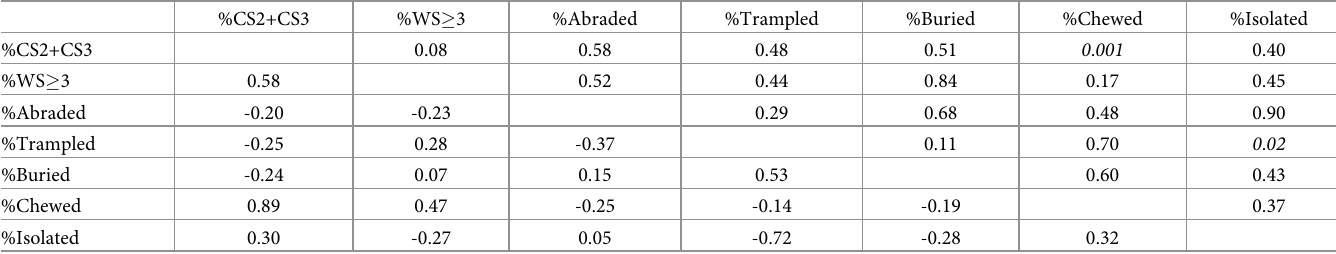
Table 5. Correlation tests between different taphonomic variables from the different habitats in Do ñ ana National Park.